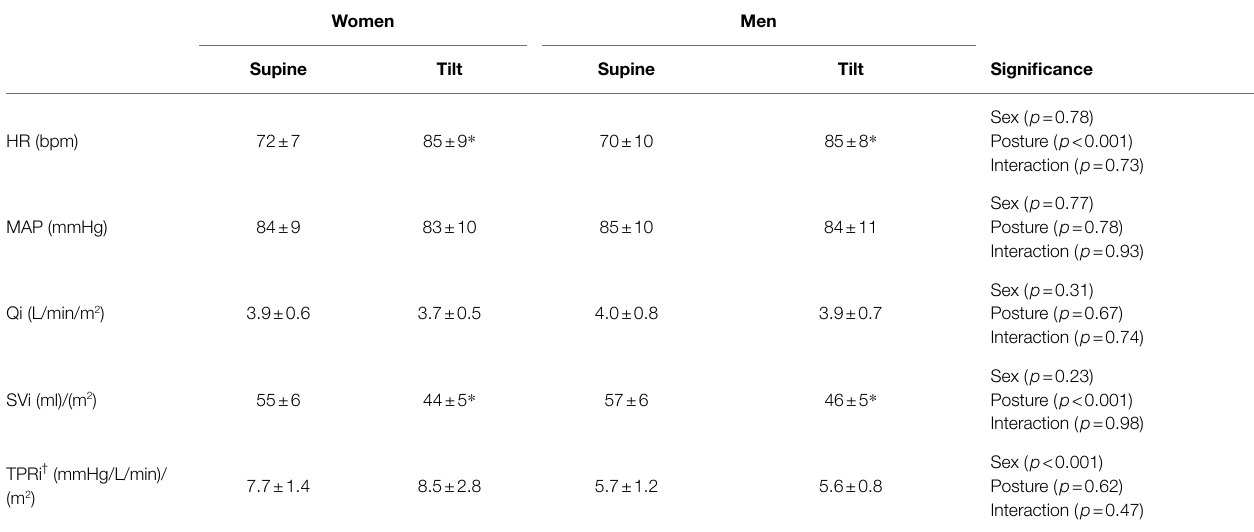
TABLE 4 | Baseline hemodynamics of women and men prior to starting the EndoPAT protocol in the supine and tilt